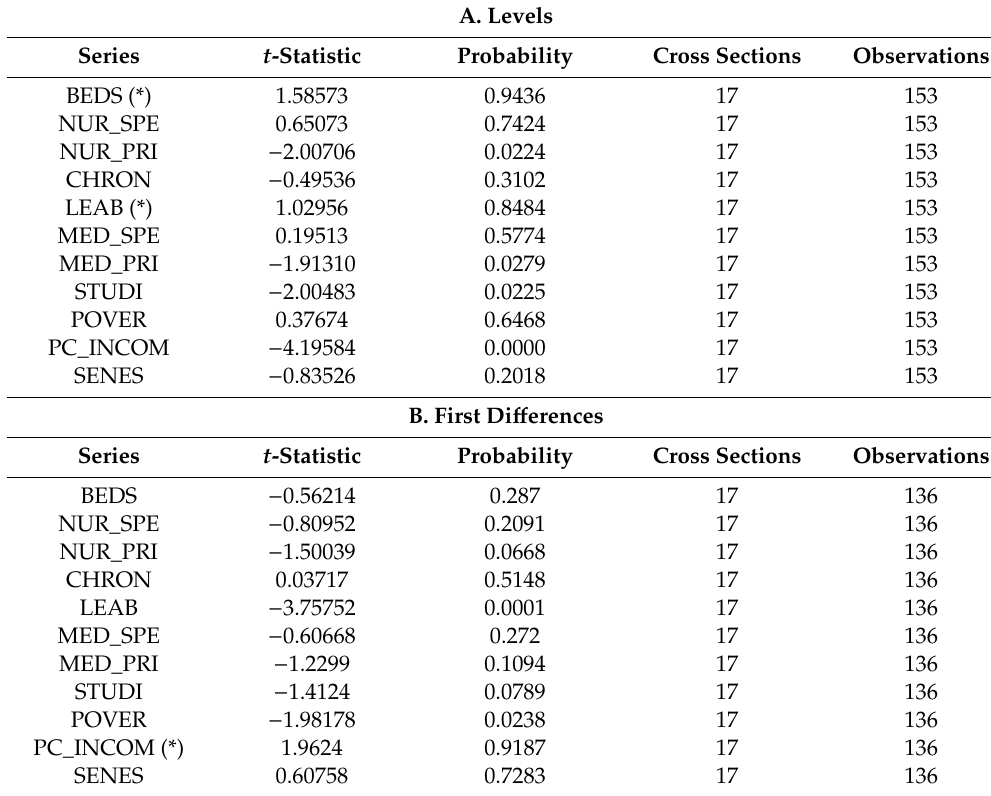
Table 3. Stationarity test by Im–Pesaran–Shim for the analyzed sample. Source: Own elaboration.